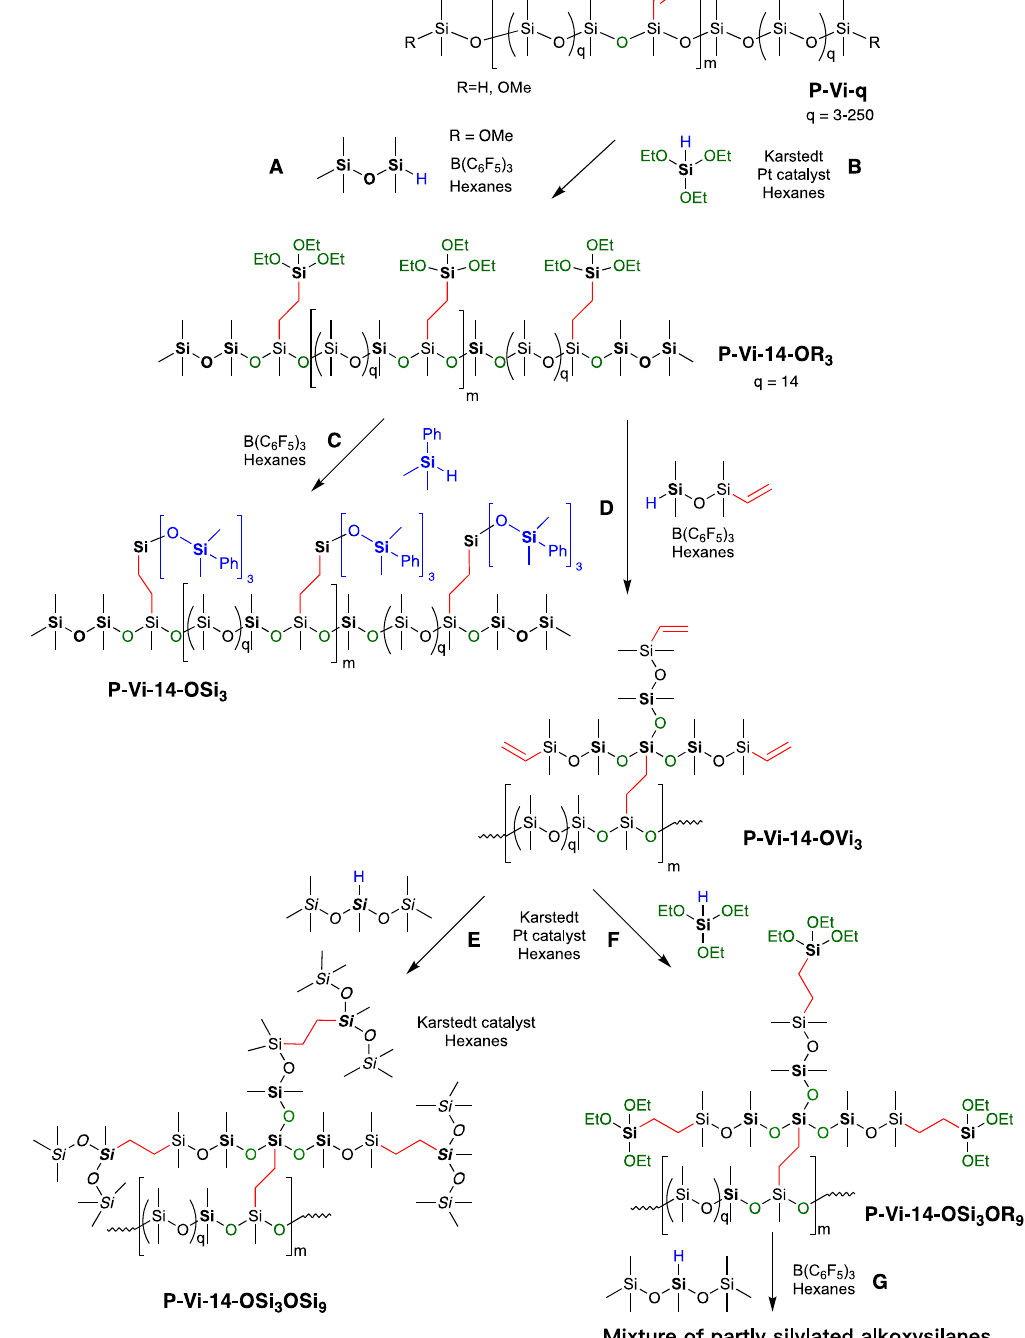
Figure 6. Synthesis of well-defined branched silicones by ( A ) capping residual SiOMe groups. ( B ) Hydrosilylation to introduce new SiOEt groups. ( C ) PR reaction to give branched siloxanes. ( D ) Chain extension to give trivinyl branches. ( E ) Dense silicone branches from hydrosilylation. ( F ) Dense alkoxysilane from hydrosilylation. ( G ) Failed attempt to extend the branches by hydrosilylation.